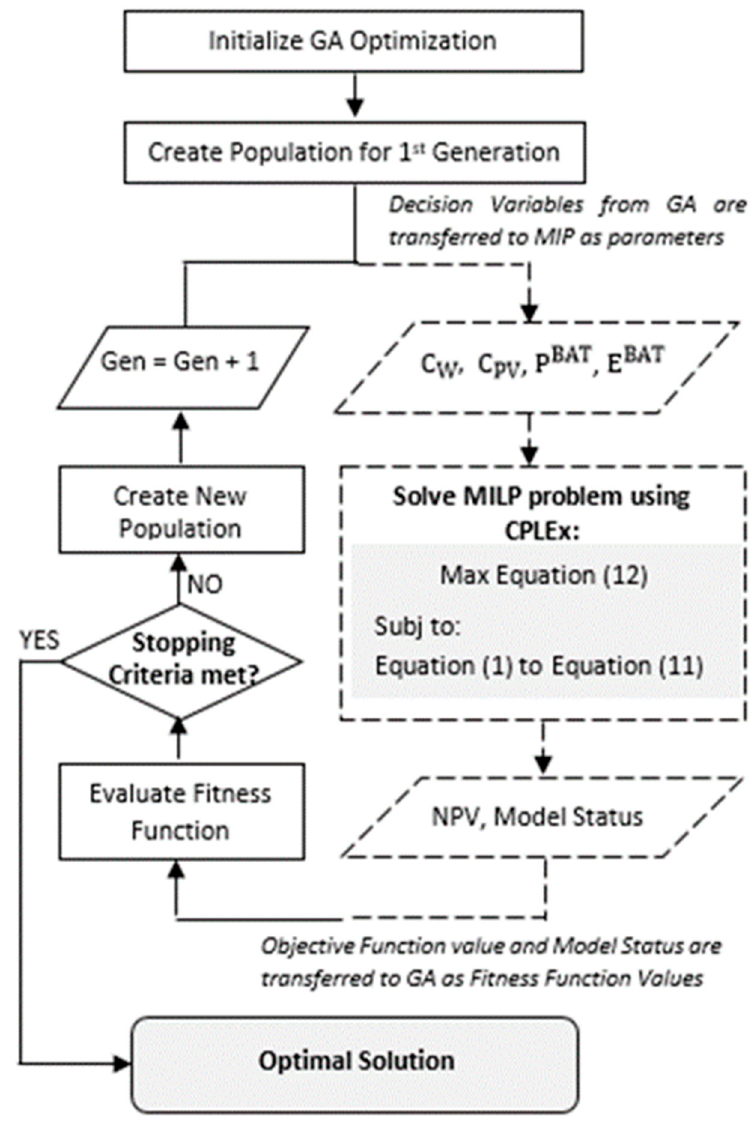
Figure 4. Flowchart of the proposed solver method. The dashes indicate the MILP part and the lines represent the GA part.